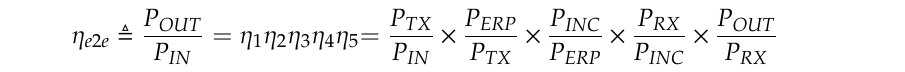
( b ) Figure 38. RFF WPT antenna [183]. ( a ) Fabricated triple-band miniaturized antenna. ( b ) Measurement setup embedded in minced pork. Copyright © 2011, IEEE.